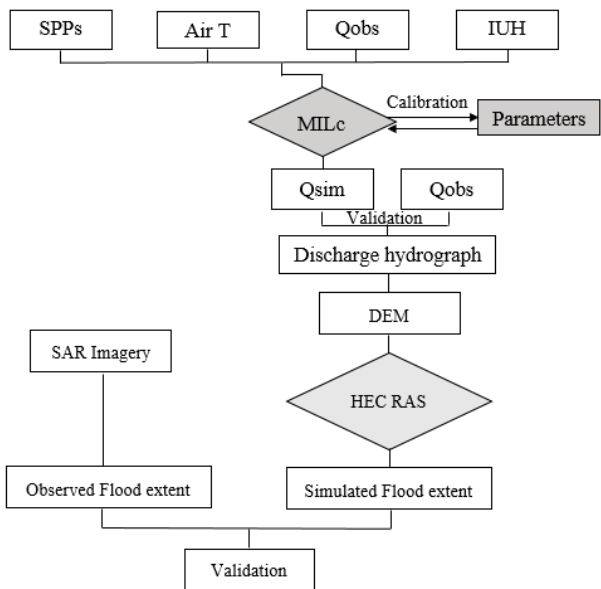
Figure 5. Hydrological flood forecasting framework based on the MILc model and SPPs. MILc = Continuous Lumped Hydrological Model; SPPs = satellite precipitation products; Air T = air temperature; IUH = instantaneous unit hydrograph; Qobs = observed discharge and Qsim = simulated discharge. Flood extent mapping based on the Hydrological Engineering Center River Analysis System (HEC-RAS) model and forecasted discharge hydrographs from SSPs and RadarSat-2 imagery during the flood event is used for accuracy assessment and validation of the framework.